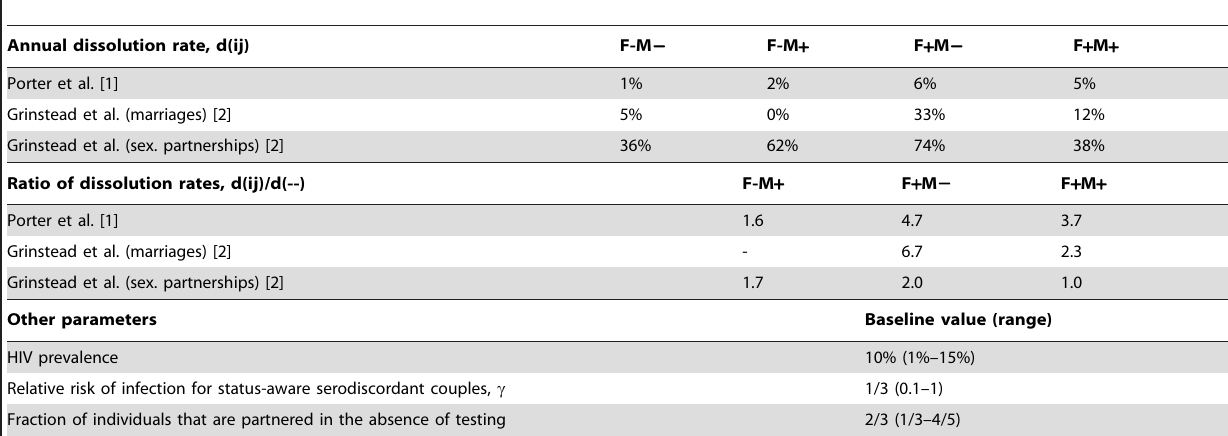
Table 1. Annual partnership dissolution rates by HIV status of the couple, and other parameter values.